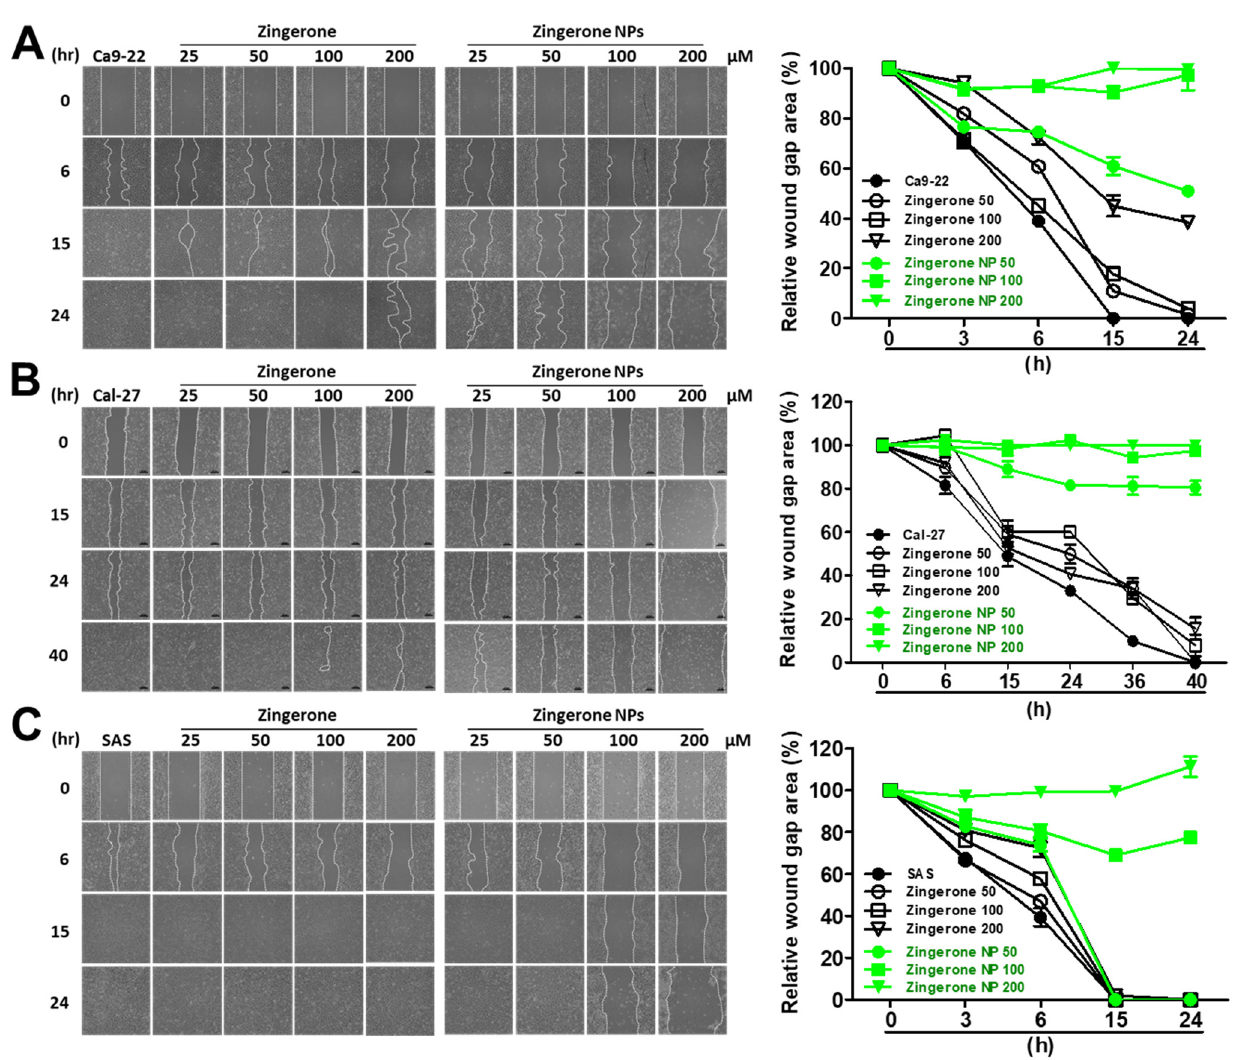
Figure 3. Effect of nanosized zingerone on cell motility of human OSCC cell lines . Dose and time effects of zingerone NPs on ( A ) Ca9-22 cells, ( B ) Ca1-27 cells, and ( C ) SAS cells were validated and imaged using wound scratch assays. The percentages of gap healing were further analyzed and quantified at the indicated time intervals (right panels). Data are mean ± SEM of at least three independent experiments.